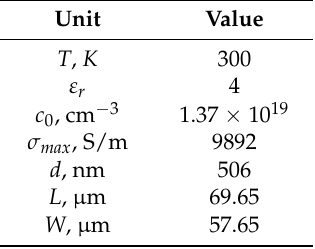
Table 1. Parameters used for the calculation of the output and transfer